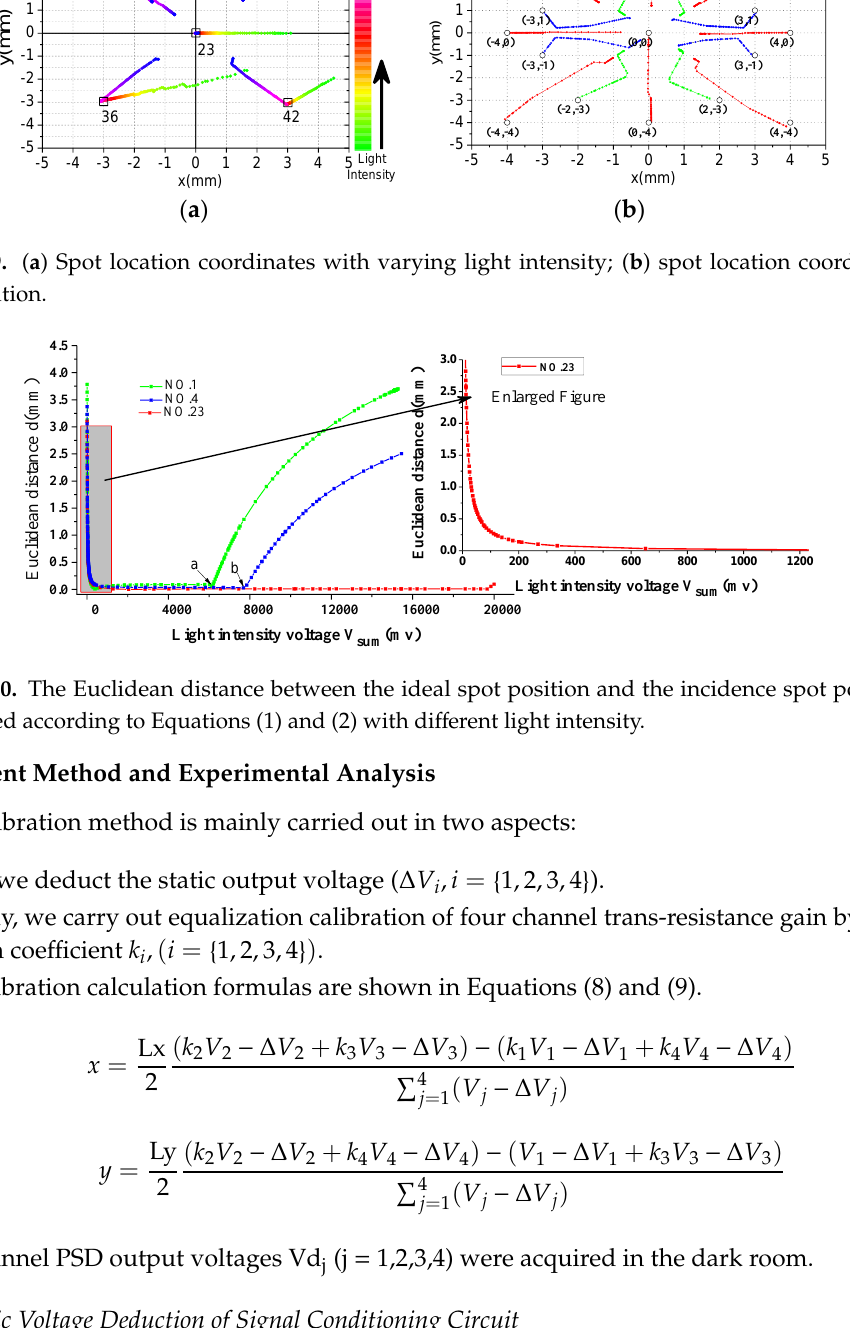
Figure 10. The Euclidean distance between the ideal spot position and the incidence spot position calculated according to Equations (1) and (2) with different light intensity.